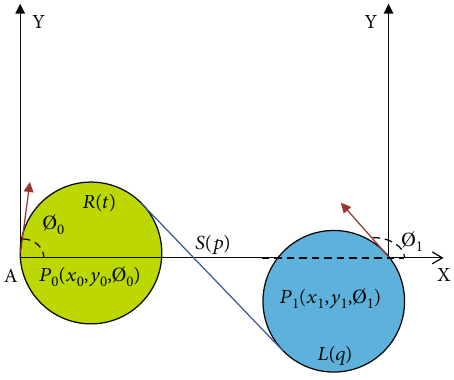
Figure 4: Schematic diagram of